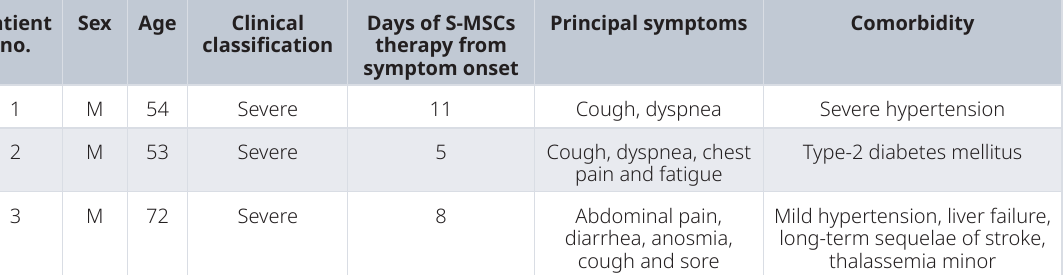
Table 1. Clinical characteristics of COVID-19 patients receiving